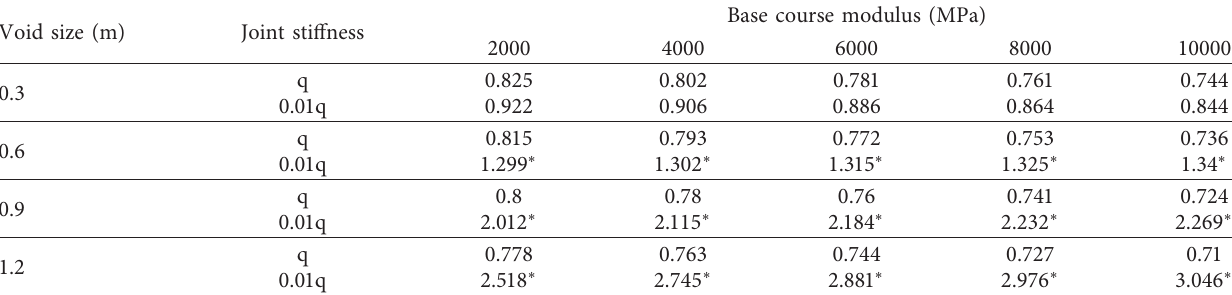
Table 5: The location of the stress under different conditions.